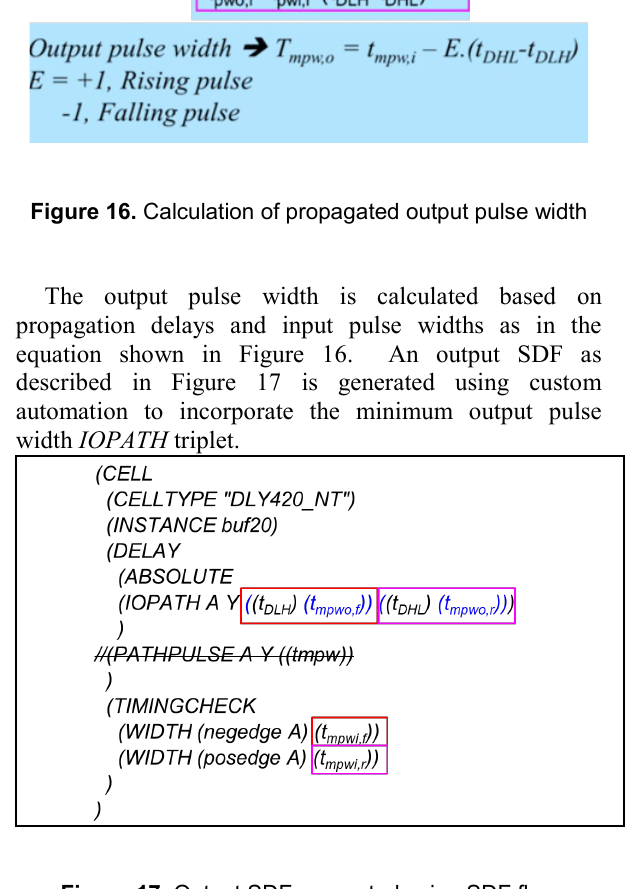
Figure 17. Output SDF generated using SDF